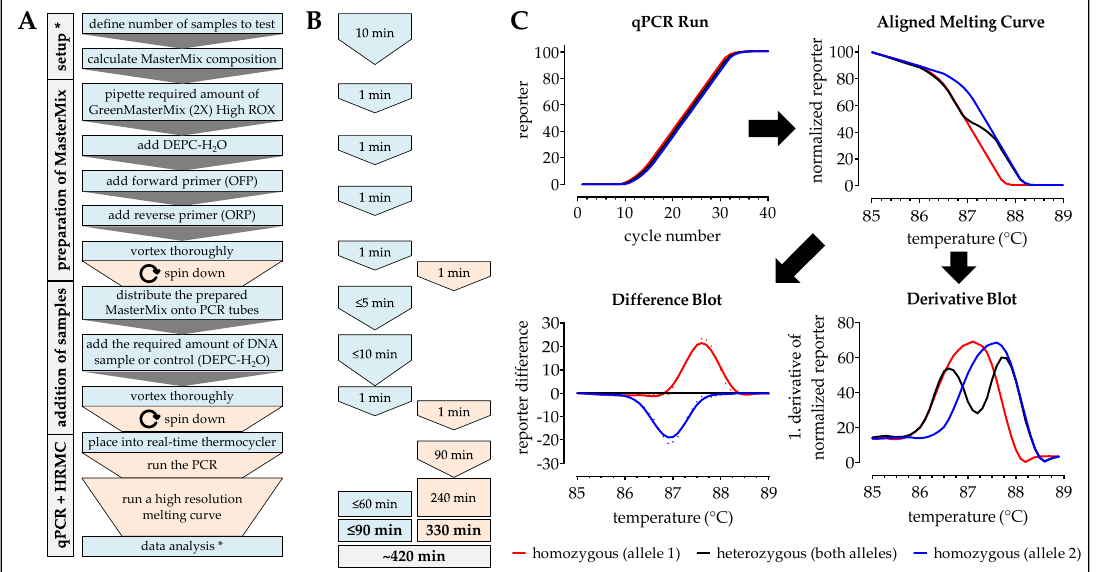
Figure 2. Workflow, timing, and expected results for the analysis of SNPs using the high resolution melting curves (HRM)-PCR method. In ( A ) workflow and ( B ) timing the blue color marks handling steps (time) of the experimenter and the orange color marks pause times caused by the procedure. ( C ) Expected results: While the PCR is running fluorescent (SYBR green) signal should increase comparably between all samples. The following high resolution melting analysis includes an aligned melting curve, as well as the resulting difference blot (difference of the normalized reporter with heterozygous samples as reference) and derivative blot (1. derivative of the normalized reporter). * When the method is frequently done a calculation matrix should be used.